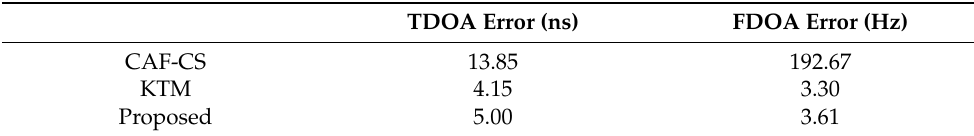
Table 5. Results of experimental data.